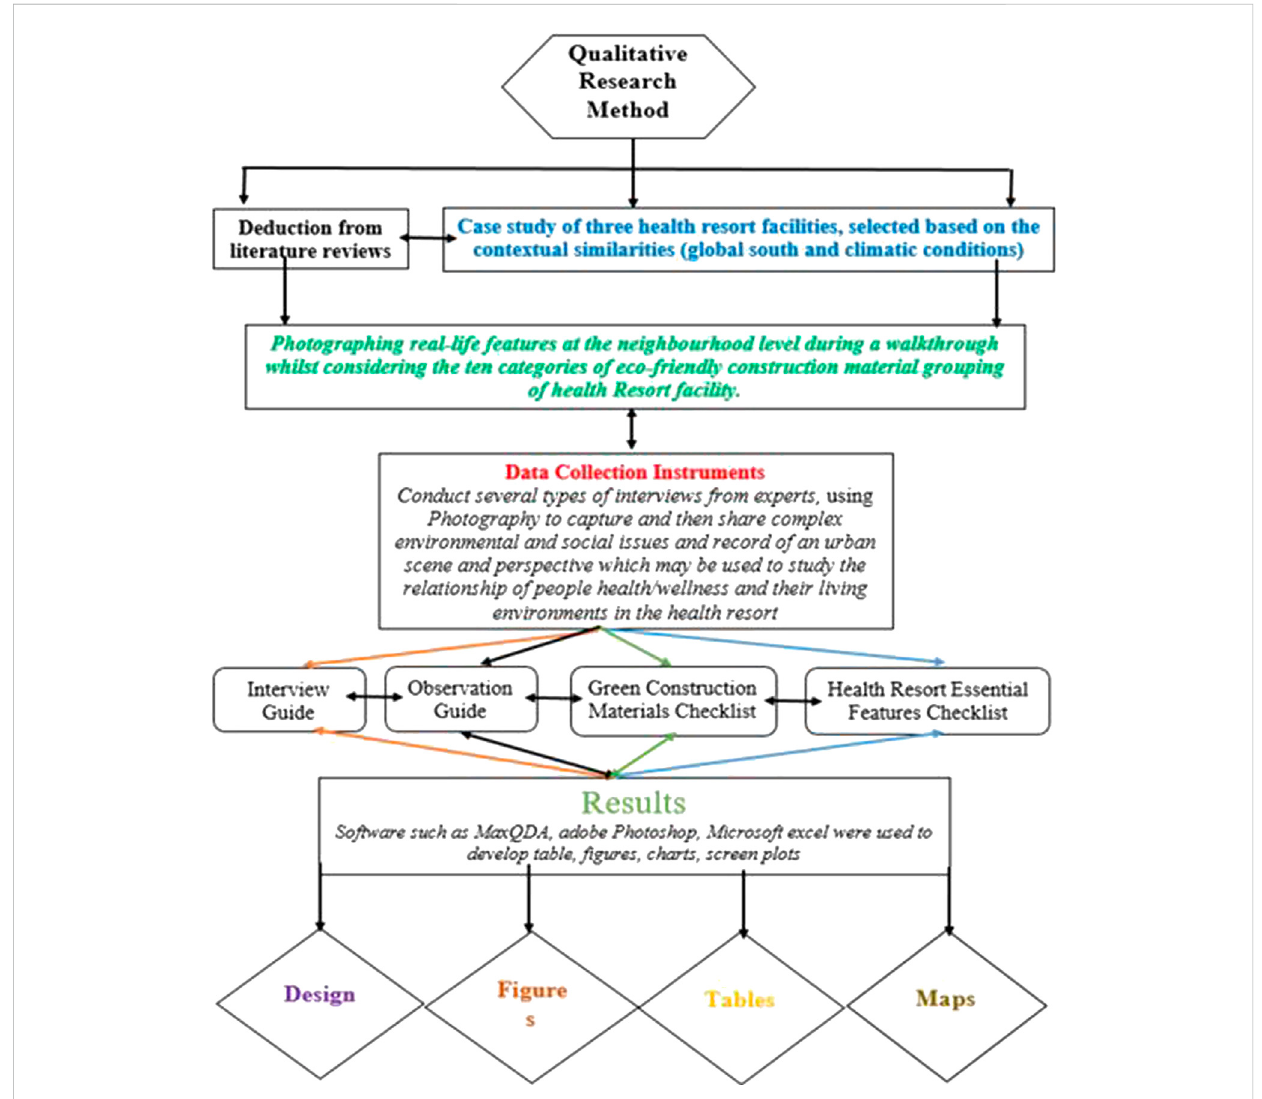
FIGURE 1 Structure of the research method, Source: Ekhaese and Ndimako